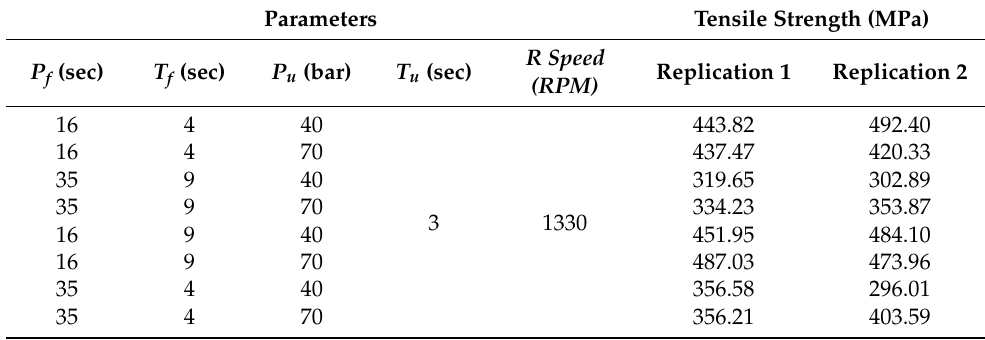
Table 7. Tensile strength of RFW low-carbon steel–304 SS.